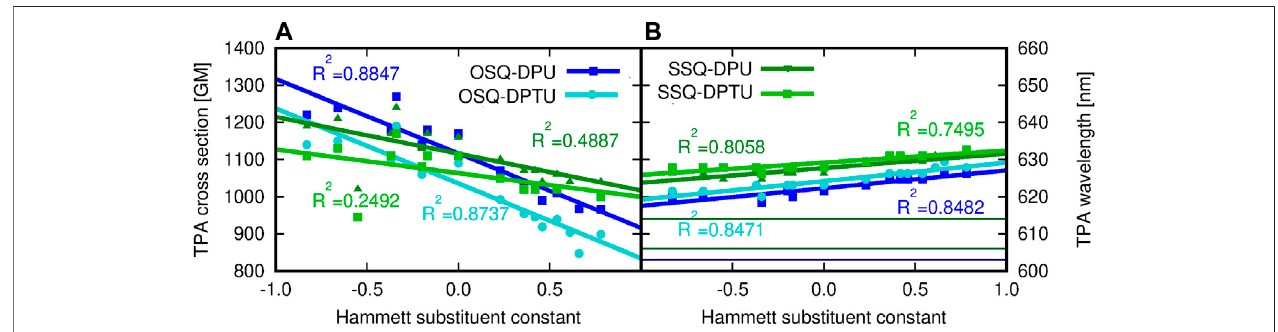
FIGURE 15 | (A) Two-photon absorption cross section (GM) and (B) two-photon absorption wavelength (nm) for the investigated complexes versus the Hammett substituentconstant,determinedwithintheCAM-B3LYP/6-31+G(d)approach(forcomparison,theTPAwavelengthofisolatedspeciesareequalto603and614 nmfor OSQ and SSQ,